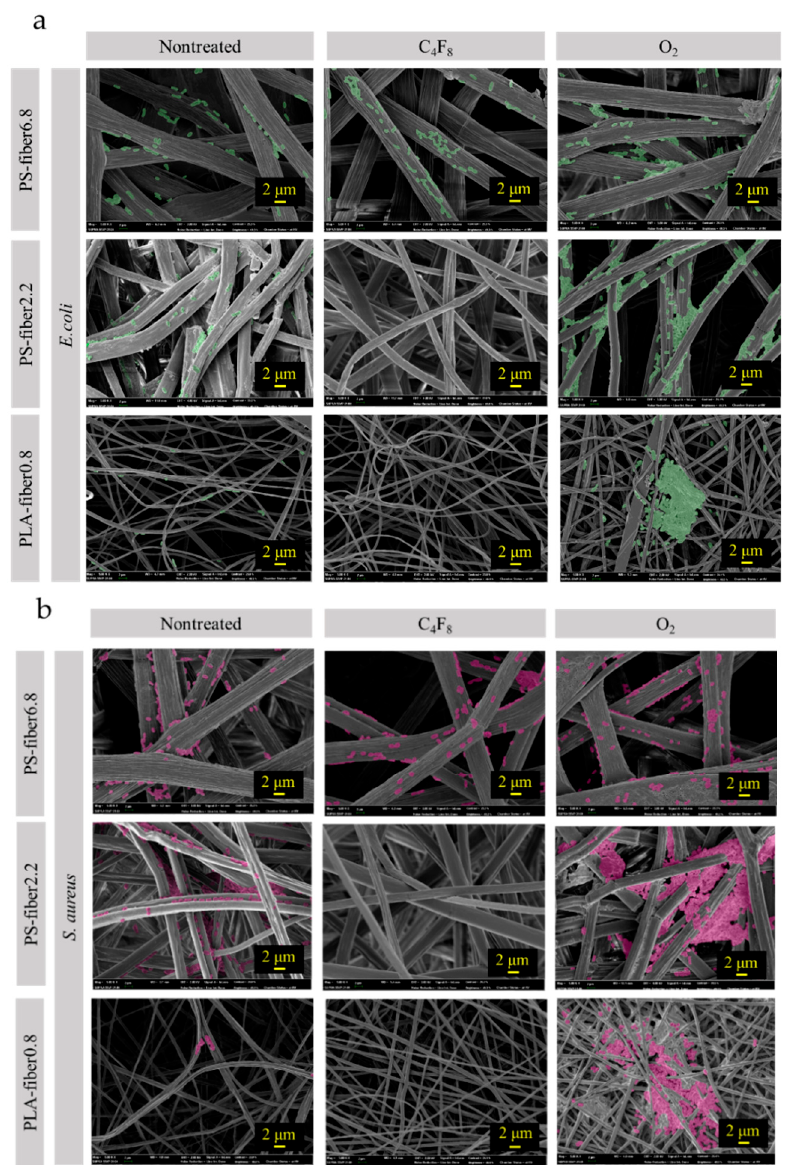
Figure 3 . Bacterial adhesion on different substrates. ( a ) E. coli ; ( b ) S. aureus